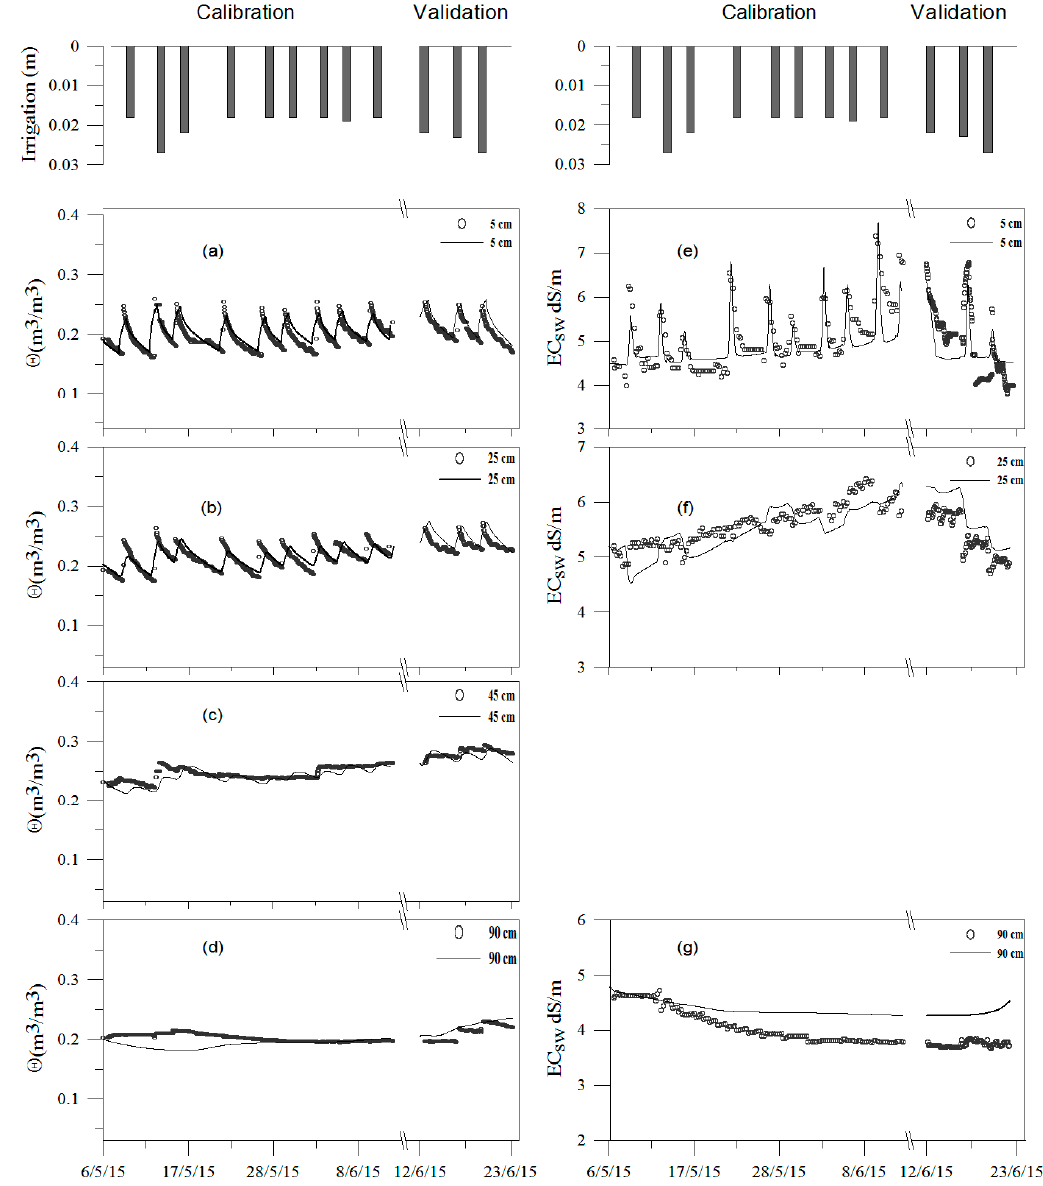
Figure 2. Simulated (solid line) versus measured (dots) soil water content ( θ ) for soil depths ( a ) 5 cm, ( b ) 25 cm ( c ) 45 cm, and ( d ) 90 cm and pore electrical conductivity (ECsw) for soil depths ( e ) 5 cm, ( f ) 25 cm, and ( g ) 90 cm and applied irrigation amounts.